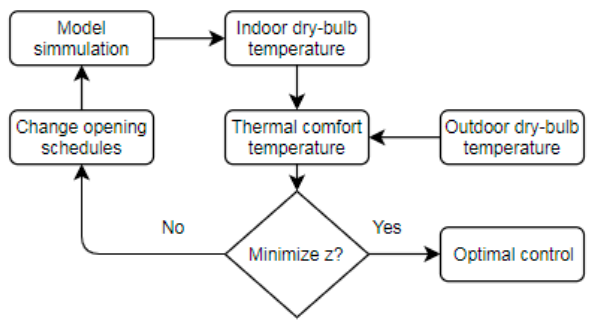
Figure 2. Flow diagram for model-based optimal control of window